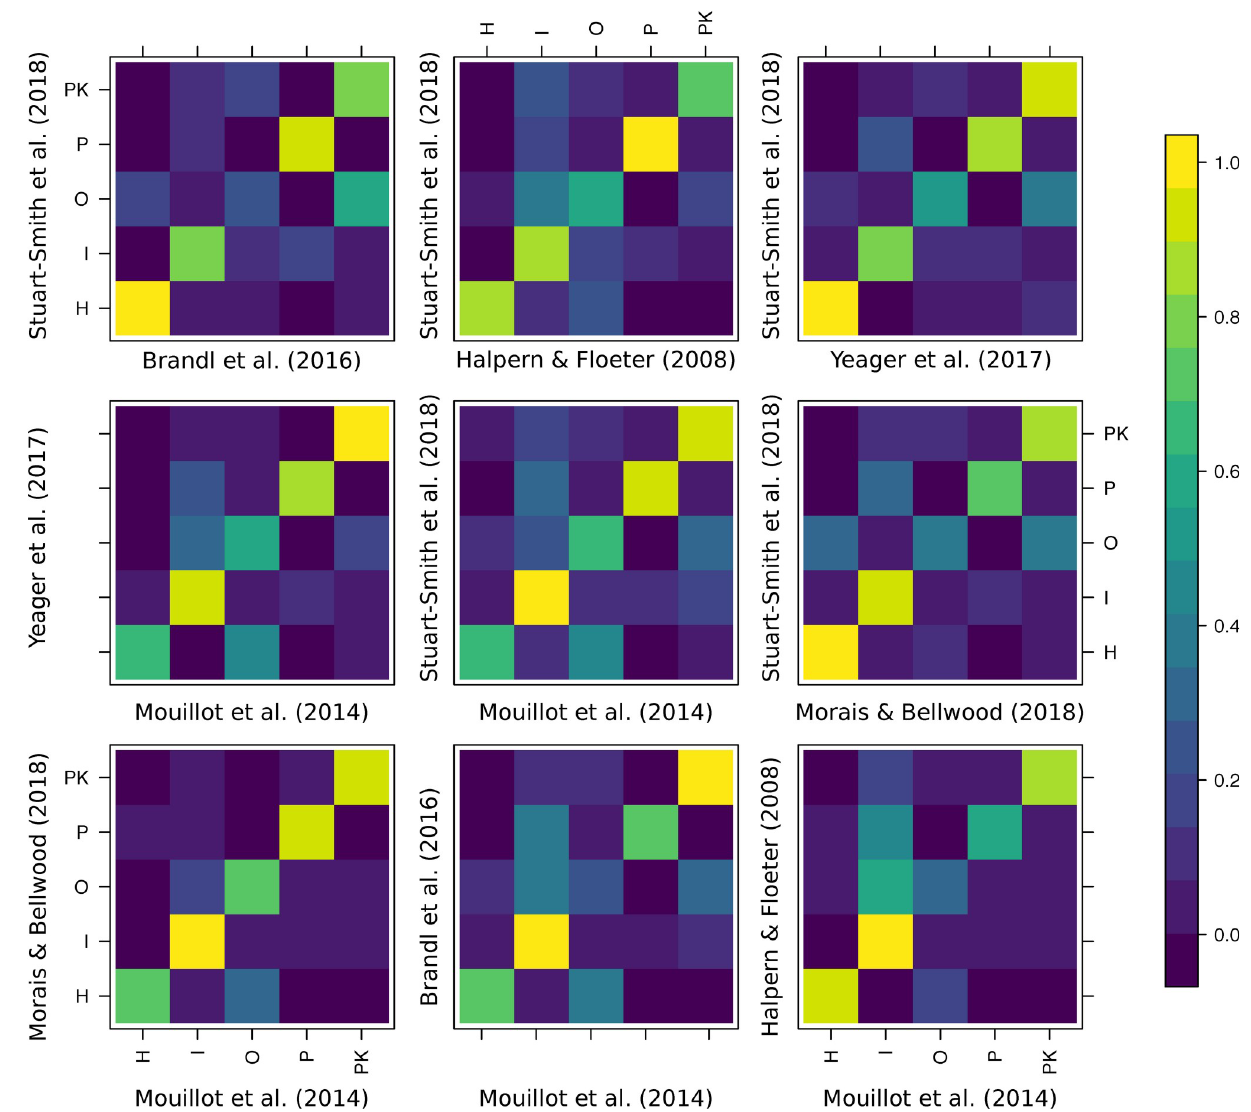
Fig 2. Confusion matrices of the agreement between pairs of experts that share at least 200 species in common and define all 5 trophic categories. Colors represent proportions of species in each trophic guild as classified by experts. The data underlying this figure may be found in